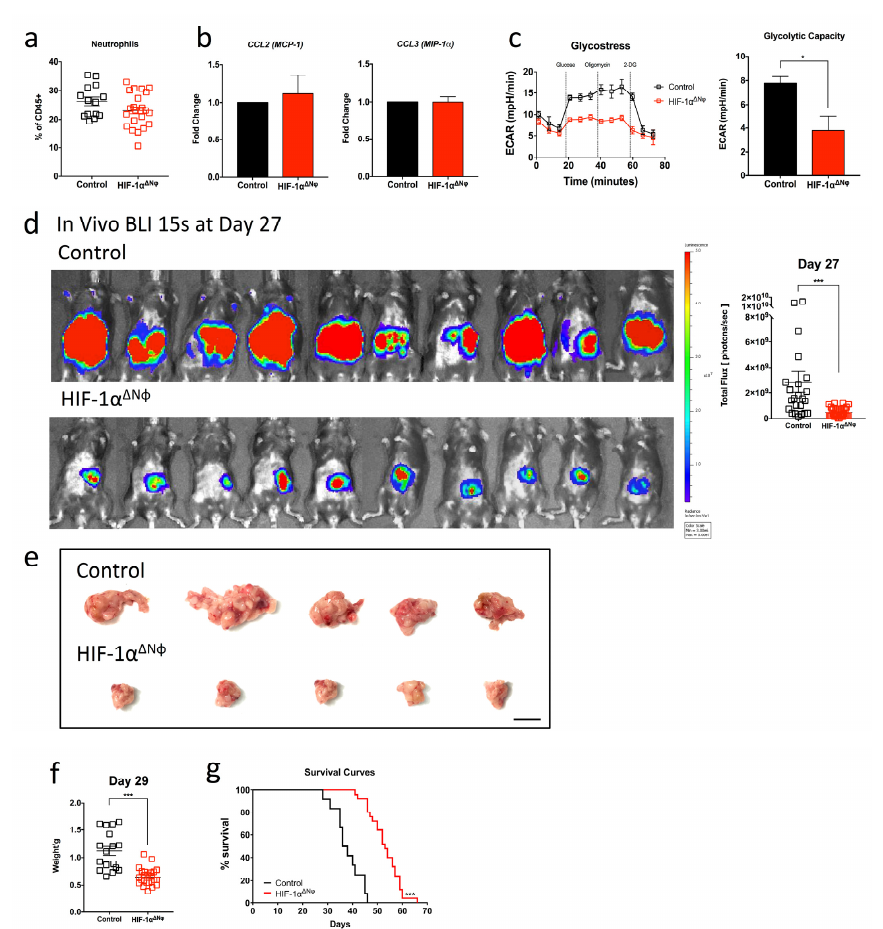
Figure 4. Neutrophil-specific HIF-1 α deletion significantly attenuates tumor burden ( a ) Pancreatic tumors from tumor-bearing HIF-1 α ∆ N ϕ orthotopic transplanted (OT) and littermate HIF- 1 α fl/fl control OT mice were harvested at day 28 post transplantation and the myeloid cell popu- lations were assessed by flow cytometry. The scatter plot of infiltrating neutrophils (Dapi-CD45 + Lin(CD3/B220/NK1.1) − Ly6G + Ly6C+) are plotted as a percentage of total CD45+ cells, from HIF- 1 α ∆ N ϕ OT mice (red clear) and littermate HIF-1 α fl/fl controls (black clear) (OT n = 23, sham n = 14; of three independent experiments, pooled). ( b ) Pancreatic neutrophils were sorted from HIF-1 α ∆ N ϕ mice and littermate controls and gene expression of CCL2 and CCL3 was assessed by quantitative PCR ( n = 3 mice, three independent experiments). ( c ) Sorted neutrophils from HIF-1 α ∆ N ϕ OT and control OT mice were rested at 37 ◦ C for 1 h and assessed for their glycolytic capacity by live metabolic flux assay. A representative Seahorse extracellular acidification rate (ECAR) trace of HIF-1 α ∆ N ϕ OT neutrophils (red) compared with control OT neutrophils (black) is shown ( left ). The glycolytic capacity ( right ) was calculated from the Seahorse ECAR trace ( n = 3–5 mice pooled per group, three independent experiments). ( d ) Orthotopic tumors from HIF-1 α ∆ N ϕ OT and control OT mice were monitored in vivo over time by bioluminescent imaging (BLI; left ). The total flux ( right ) on day 27 post transplantation was calculated from the BLI image (control, n = 25; HIF-1 α ∆ N ϕ , n = 34, three independent experiments pooled). BLI images were acquired at a 15-s exposure, and the color scale was set to a lower limit of 3 × 10 6 and an upper limit of 5 × 10 7 photons/sec. ( e ) Representative images of HIF-1 α ∆ N ϕ OT and control OT mice tumors. ( f ) Tumors were harvested on day 27 post transplantation and weighed. Scatter plot of orthotopic tumor weights from HIF-1 α ∆ N ϕ OT (red clear) and age-matched OT controls (black clear) (HIF-1 α ∆ N ϕ n = 24, controls n = 17; of four inde- pendent experiments pooled). ( g ) Kaplan–Meier survival analysis of HIF-1 α ∆ N ϕ OT mice ( n = 25) compared with littermate HIF-1 α fl/fl control OT mice ( n = 12). Data represent the means ± SEM, * p < 0.05; *** p < 0.001 by unpaired student’s t -test with a 95% confidence